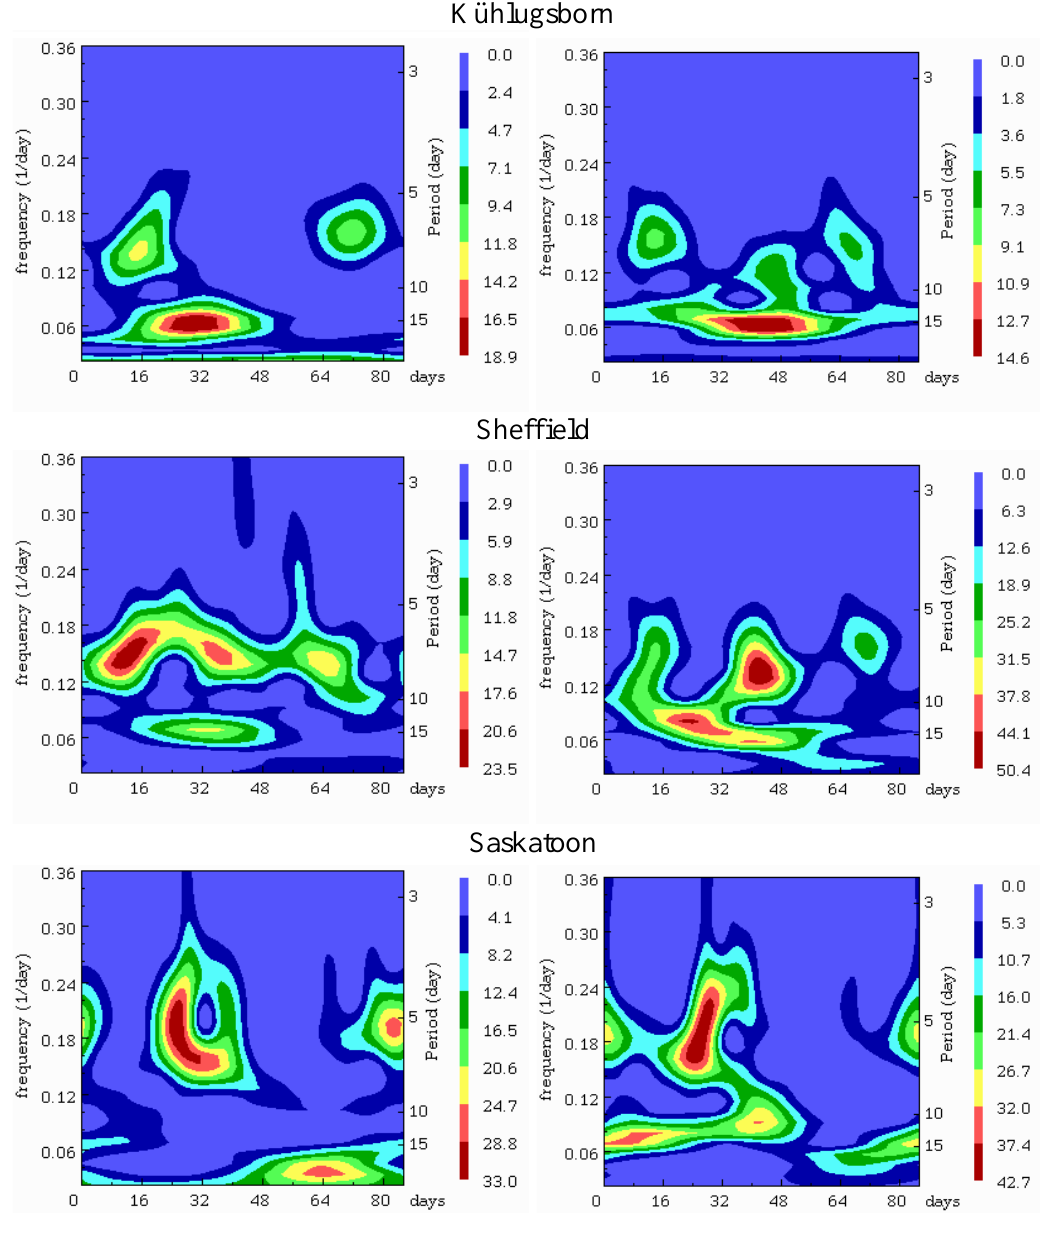
Fig. 2. As Fig. 1, but for the Western European sites.